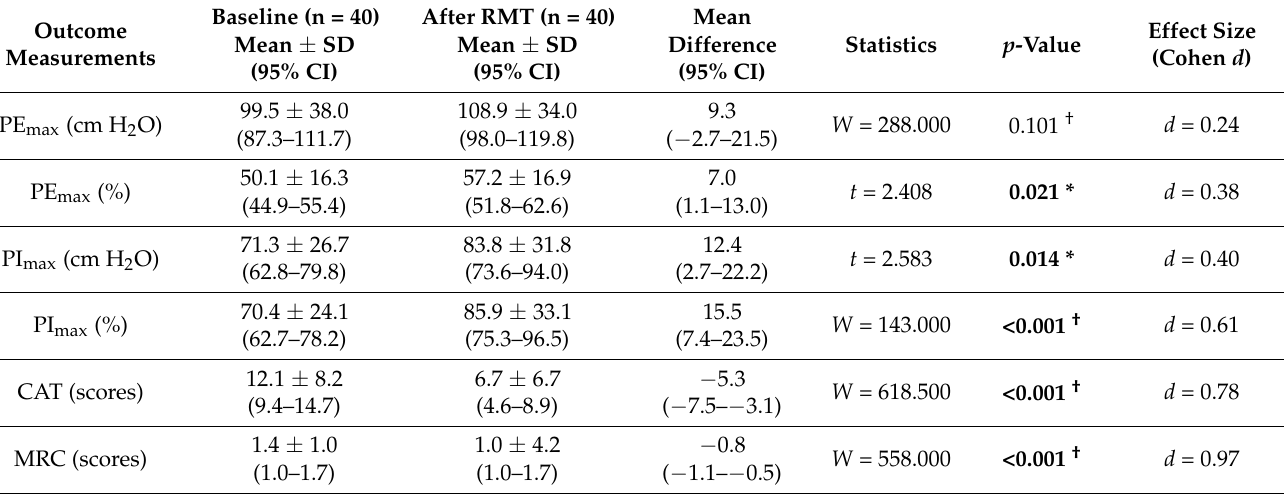
Table 3. RMT effect on the outcome measurements of the total sample of COVID-19